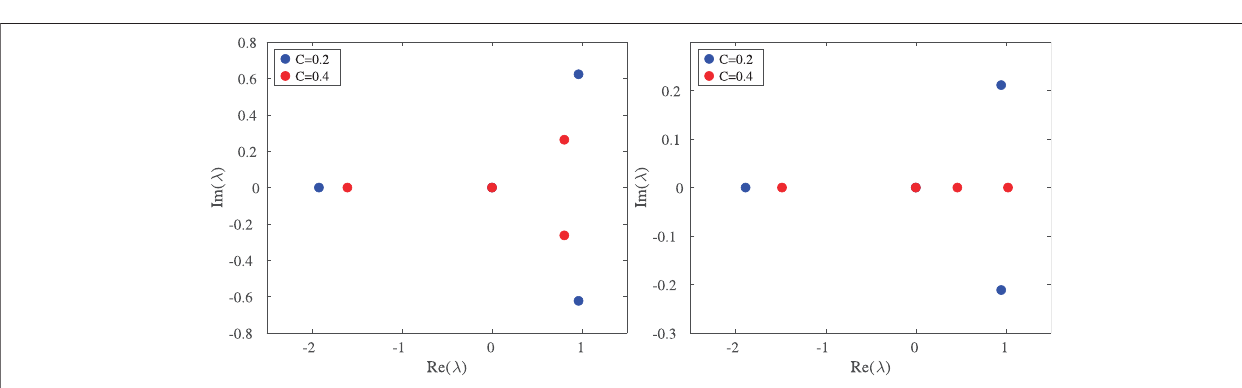
FIGURE 6 | (A,B) Spectral plane representation of eigenvalues for C = 0.2 and C = 0.4 for the upper (left panel) and lower (right panel) asymmetric branches. The rest of the parameters are the same as in the previous fi gures.